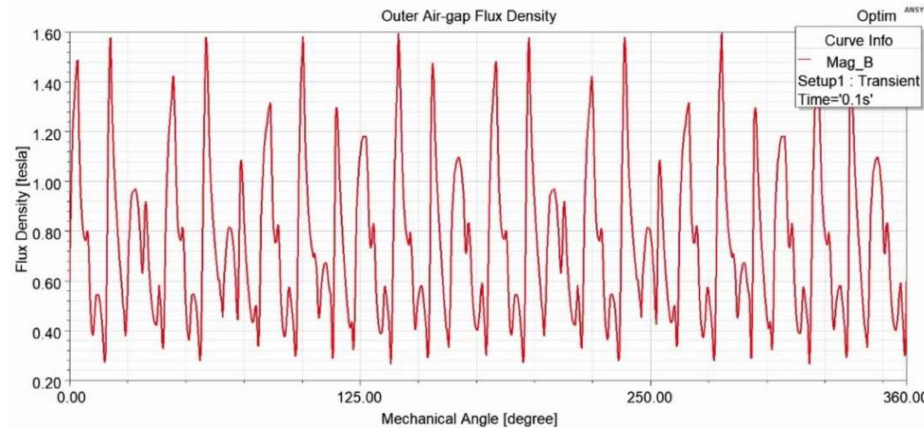
Figure 9. Outer air-gap flux density.